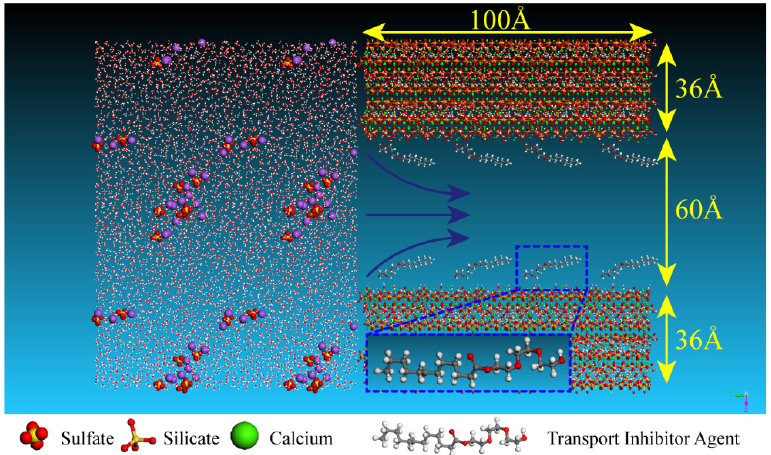
Figure 1. Schematic diagram of the calculation model (the left part is the erosive solution, the right part is the C ‐ S ‐ H gel channel, and the TIA polymers are distributed on the gel pore surface). The red, green, yellow, white, gray, purple and orange spheres represent oxygen atoms, calcium atoms, silicon atoms, hydrogen atoms, carbon atoms, sodium ions and sulfur atoms, respectively).